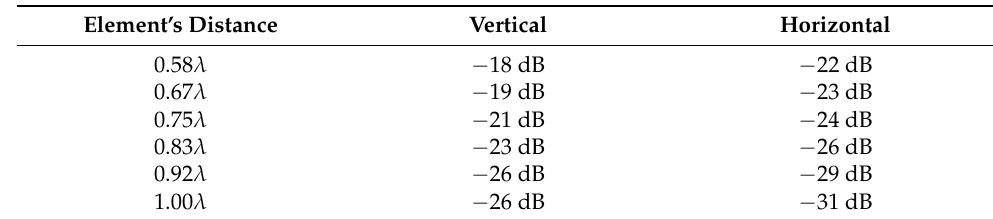
Table 5. Yagi–Uda coupling measurements between adjacent elements (S12) in the vertical and horizontal positions.